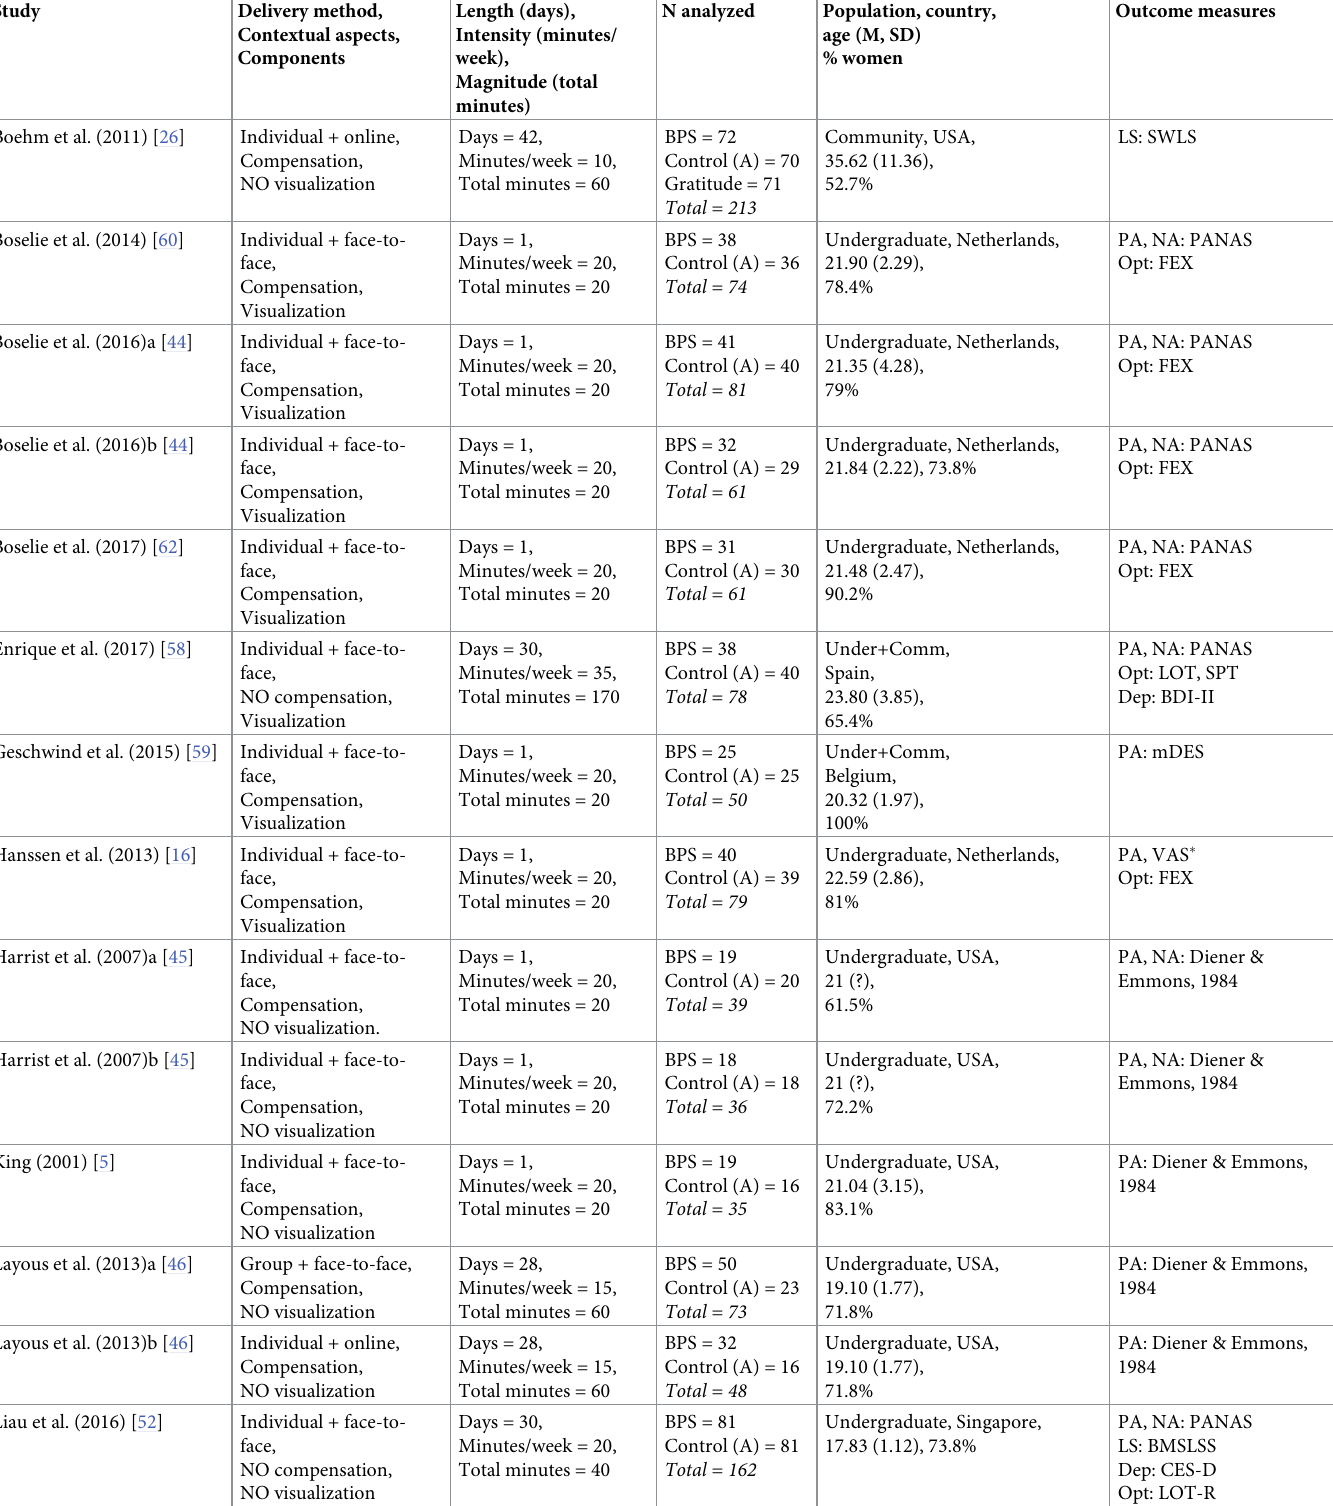
Table 1. Characteristics of the studies that examined the effects of the BPS intervention.